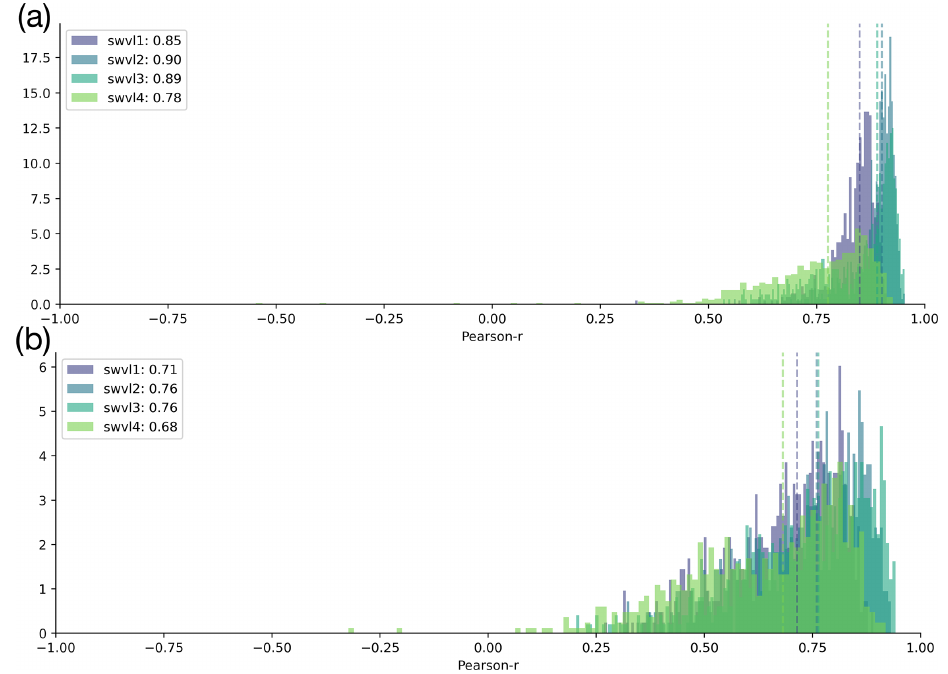
Figure A3. Shuffling in space. (a) Histograms of the original experiments with unshuffled data, repeated from Fig. 2. (b) Histograms of catchment correlation scores after having trained the probes on data shuffled in space. The performances decline quite significantly when compared with the original experiments.